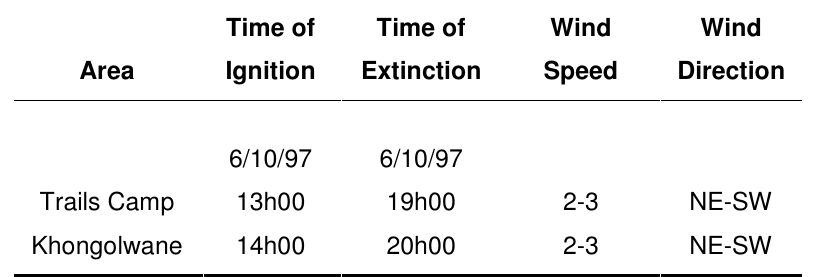
Table 4. Selected information from the fire record for the Trails Camp and Khongolwane regions of